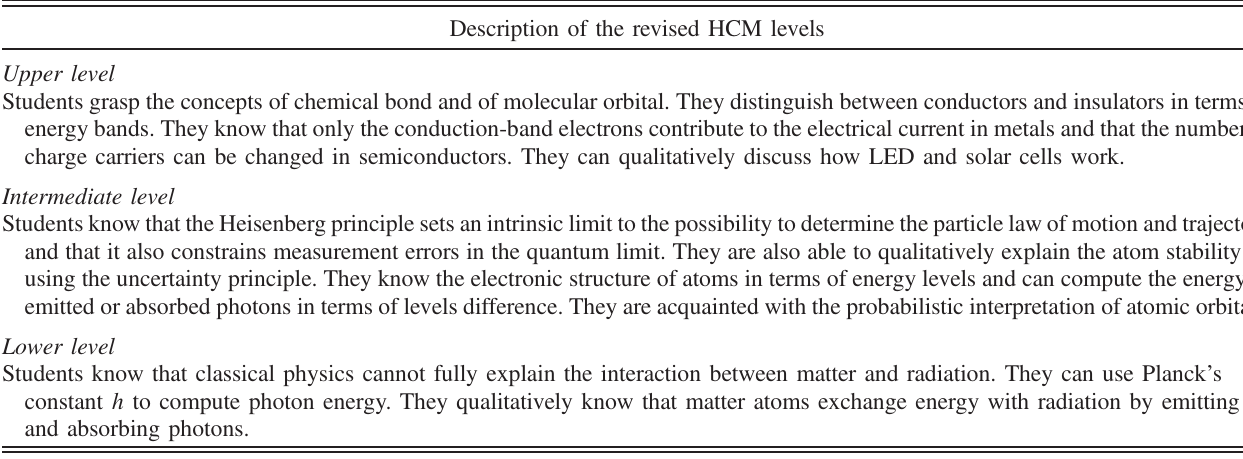
TABLE IV. Revision of the initial